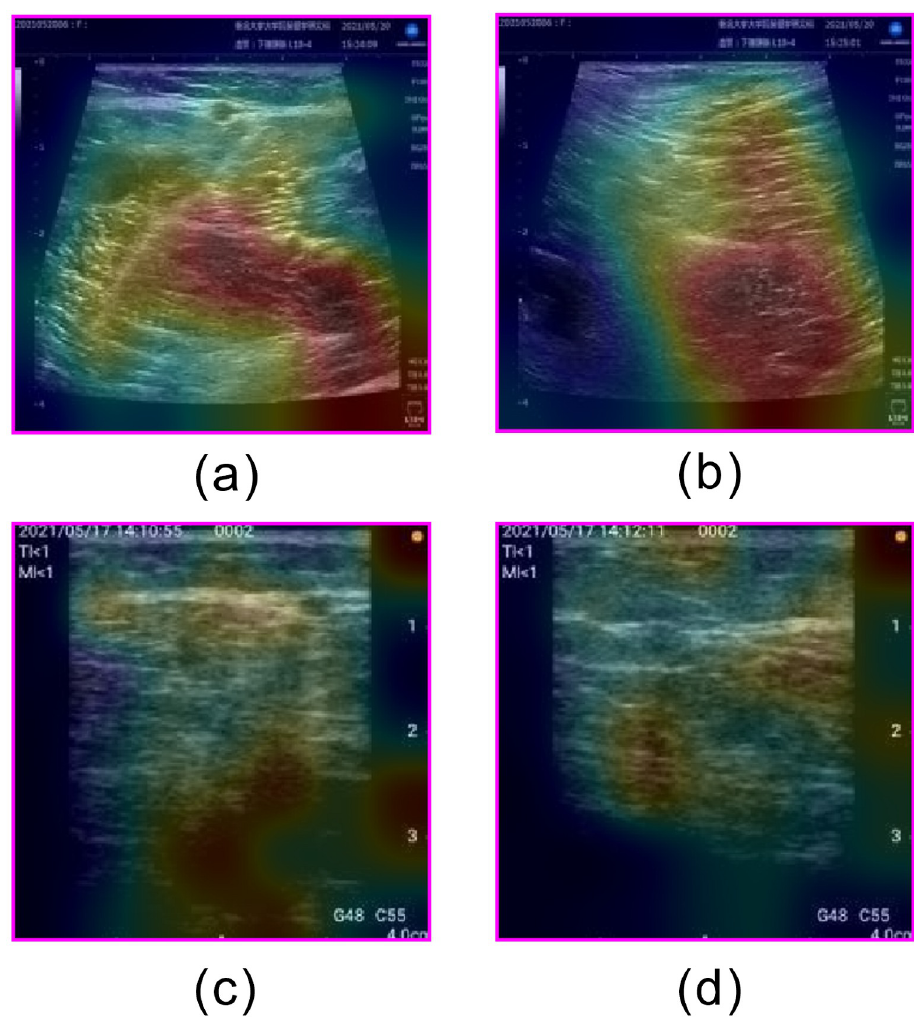
Fig 5. Examples of heatmaps for correctly classified unsatisfactory images. (a) Short axis acquired by stationary ultrasonography equipment, (b) Long axis acquired by stationary ultrasonography equipment, (c) Short axis acquired by portable ultrasonography equipment, and (d) Long axis acquired by portable ultrasonography